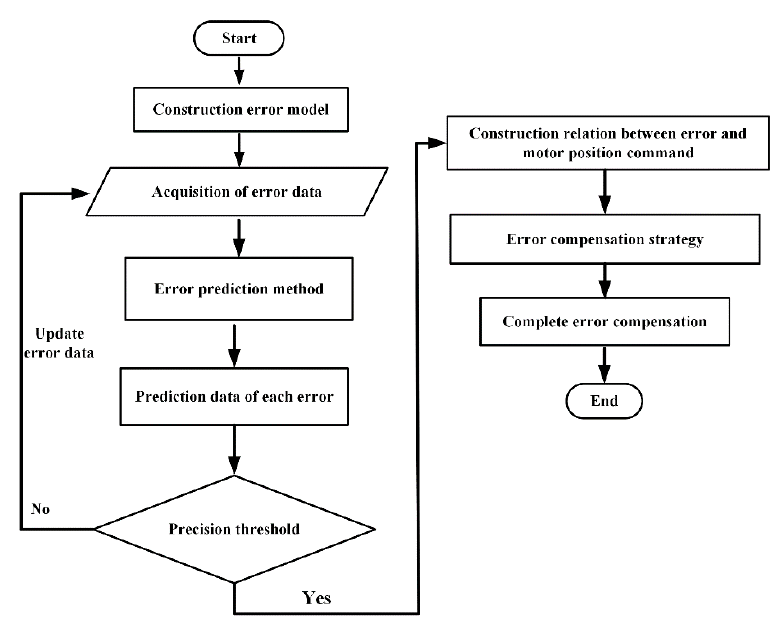
Figure 2. Flow chart of the non-delay error compensation method.